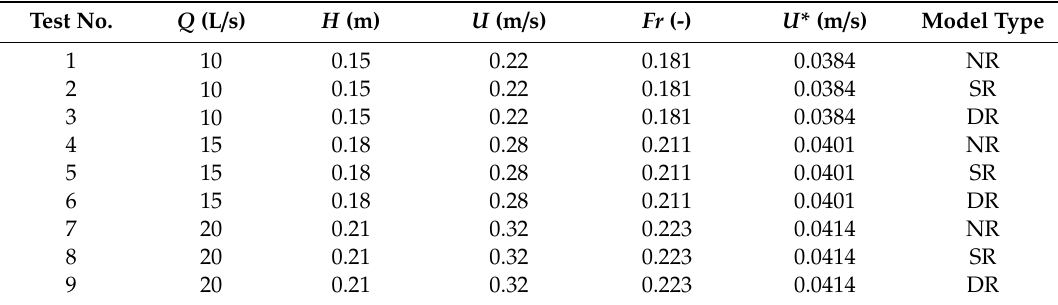
Table 1. Summary of the experimental conditions.